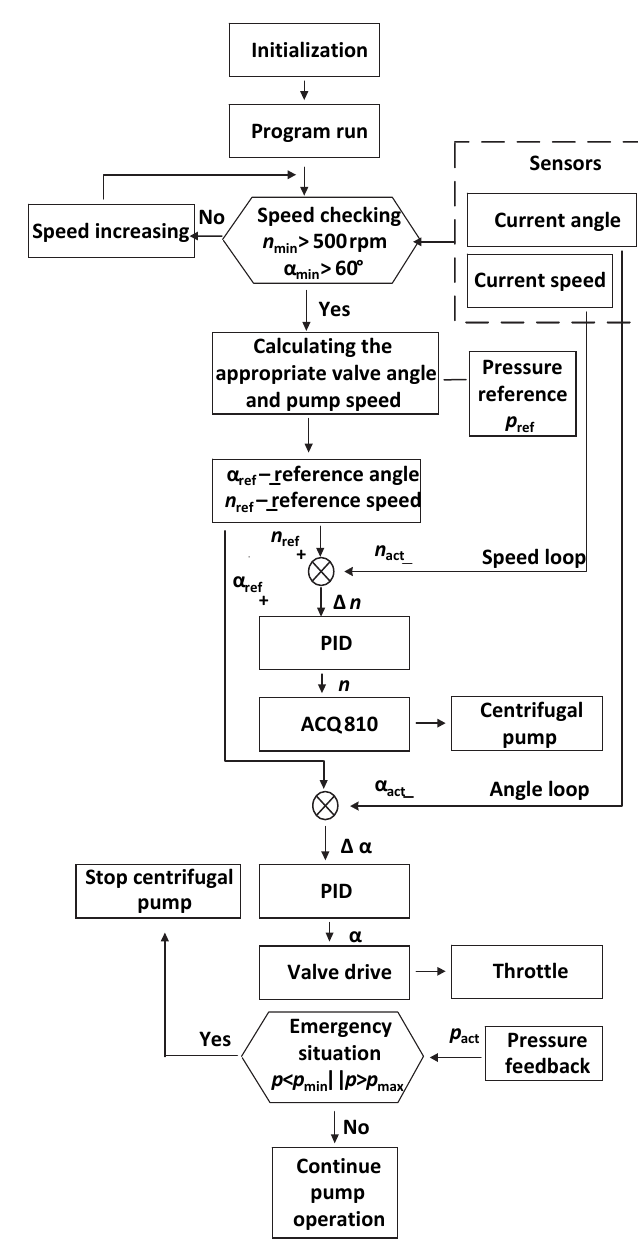
Fig. 2. Mixed control algorithm for a centrifugal pumping